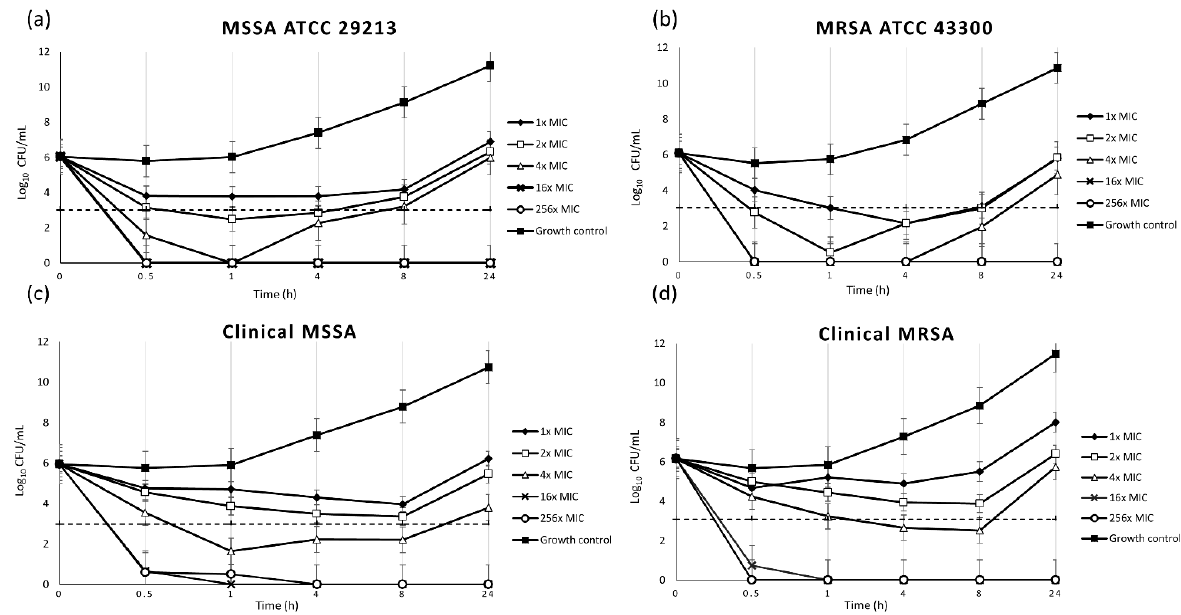
Figure 1. Time-kill curves for sodium bituminosulfonate against two reference strains ( a , b ) and two clinical strains ( c , d ) of Staphylococcus aureus . The threshold (dashed line) denotes 99.9 % decreases in CFU/mL. MSSA, methicillin-susceptible S. aureus ; MRSA, methicillin-resistant S. aureus ; MIC, minimal inhibitory concentration.